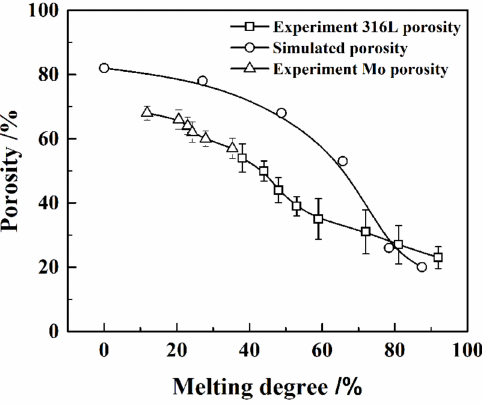
Figure 6. Relationship between melting degree of spray particles and porosity of the porous deposits.